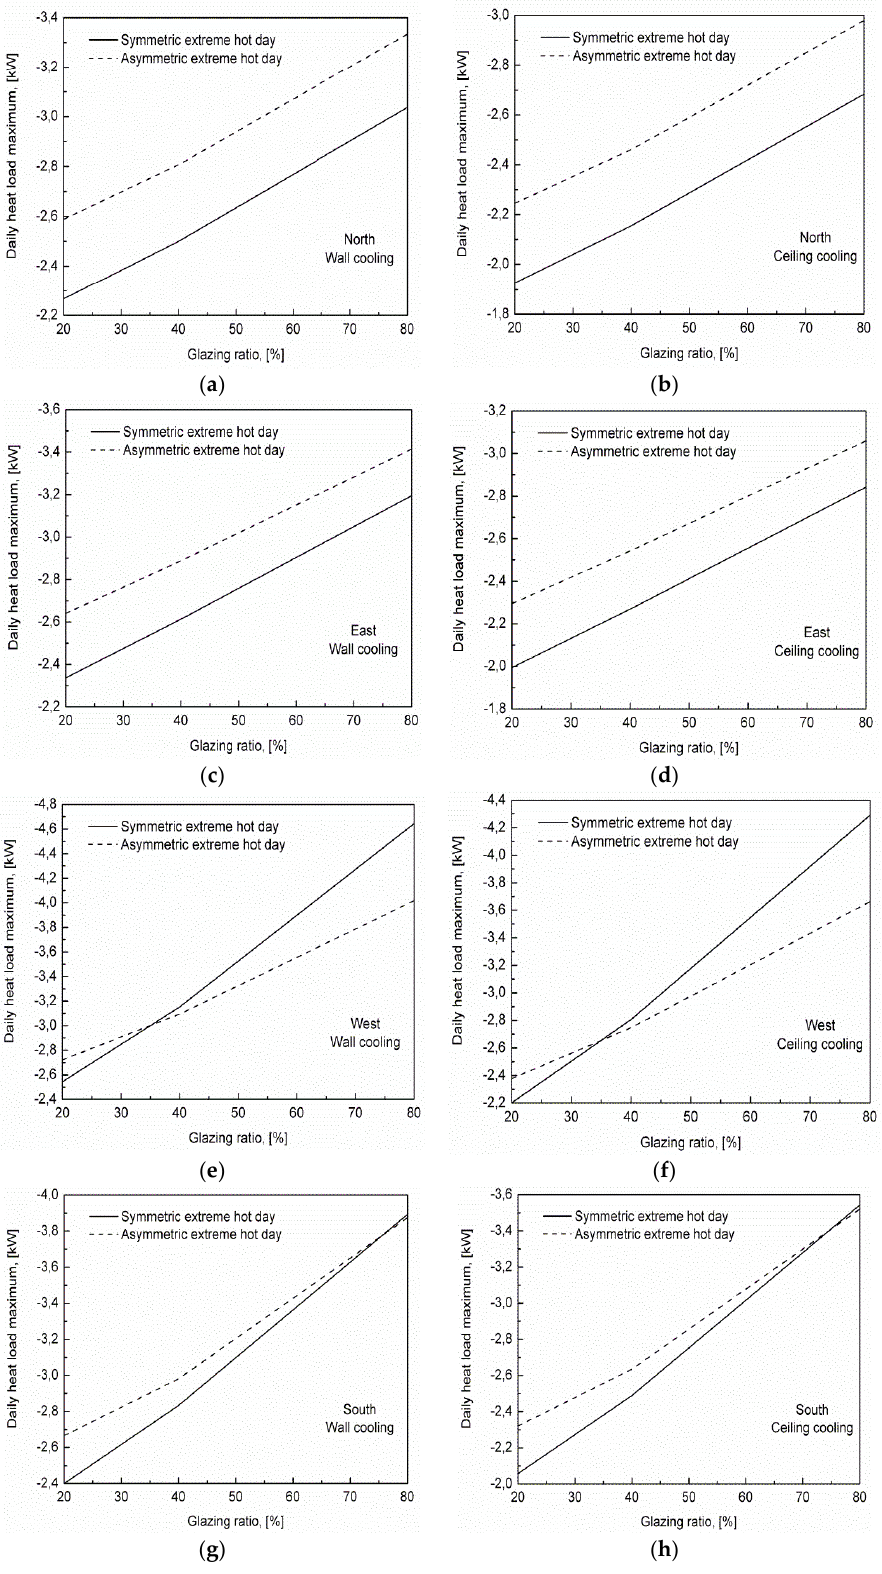
Figure 4. Interrelation between glazing ratio and the maximum of the daily heat load. ( a ) North orientation and wall cooling; ( b ) North orientation and ceiling cooling; ( c ) East orientation and wall cooling; ( d ) East orientation and ceiling cooling; ( e ) West orientation and wall cooling; ( f ) West orientation and ceiling cooling; ( g ) South orientation and wall cooling; ( h) South orientation and ceiling